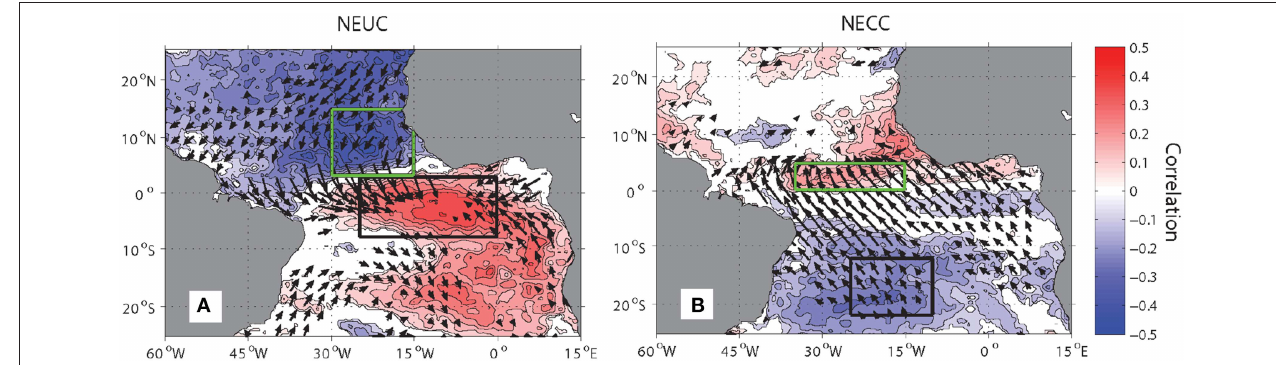
FIGURE 6 | Simultaneous correlation of monthly anomalies of tropical Atlantic SST (contour) and pseudo wind stress (vectors) with the transport of (A) North Equatorial Undercurrent (NEUC) and (B) North Equatorial Countercurrent (NECC) at interannual timescales. Anomalies are calculated relative to the monthly means. The boxes represent the regions of maximum